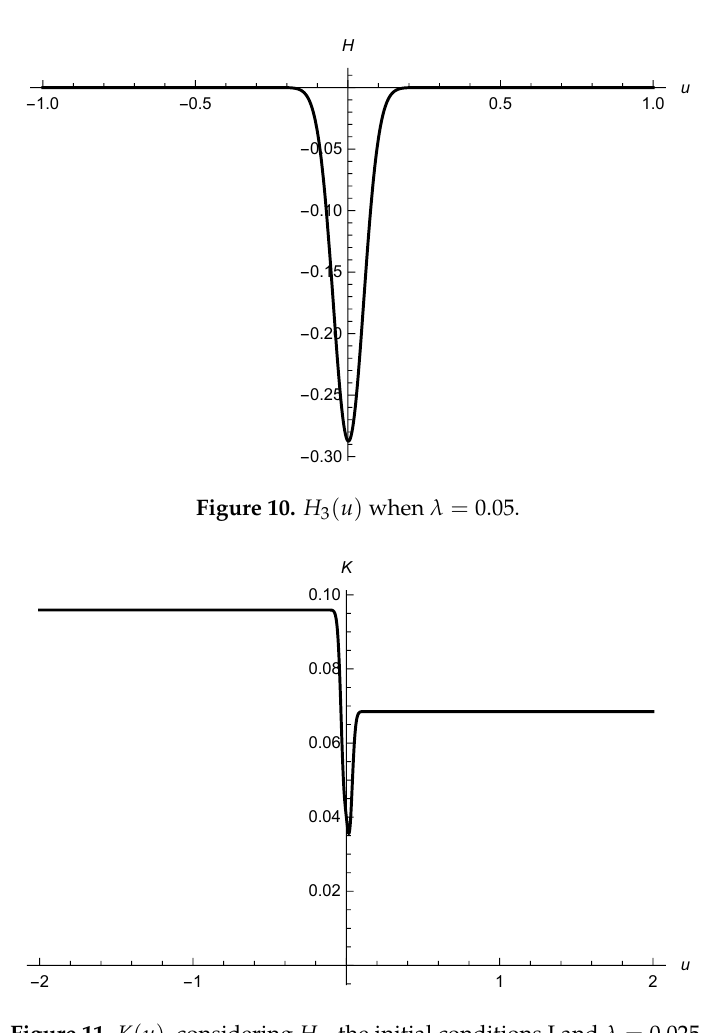
Figure 9. K ( u ) , considering H 3 , the initial conditions I and λ = 0.05.